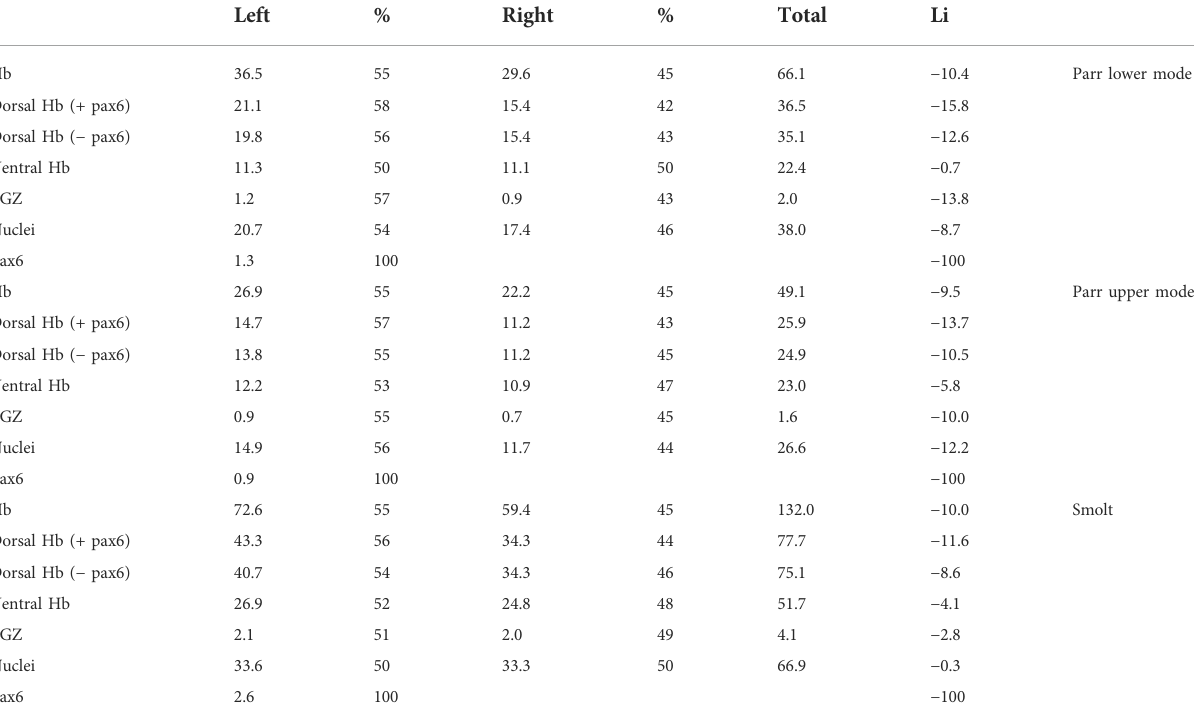
TABLE2Quanti fi cationofhabenulasubdomainvolumesinAtlanticsalmon.Volumeswerequanti fi edusinghabenula3Dreconstructionsforoneparr lower mode, one par upper mode and one smolt, same specimen as in Table 1. Abbreviations for subdomains are the same as in Table 1. Volumes for left subdomains, right subdomains and corresponding left plus right subdomains are indicated in columns 2, 4 and 6 respectively. The ratio occupied bytheleftor rightcomponentrelativetotheirsumisindicatedaspercentage(%)incolumns 3and5, thecorresponding laterality index